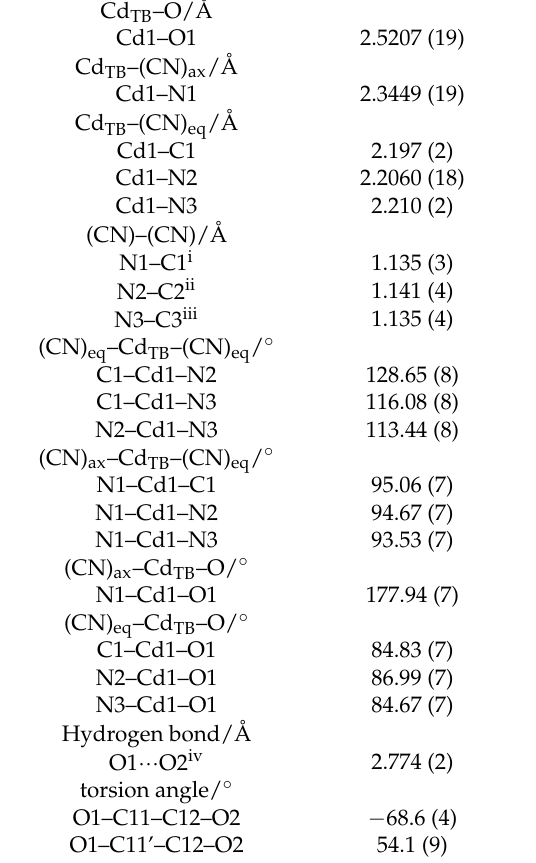
Table 2. Selected Parameters for I